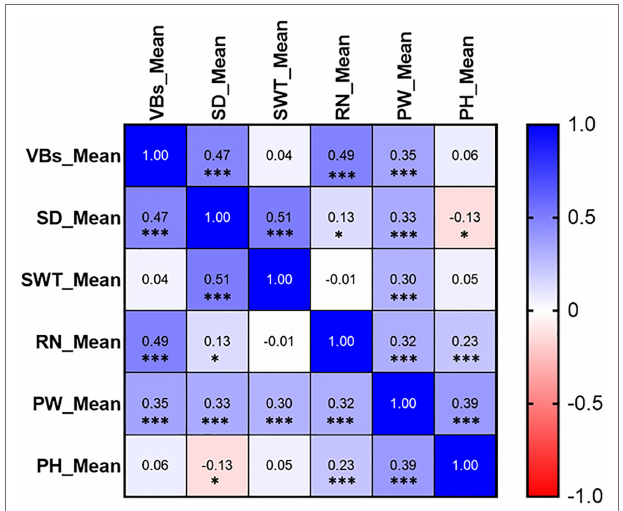
FIGURE 4 | Correlations between stem- and yield-related traits. The number in the middle of the cell is the correlation coefficient; “ * ” and “ *** ” refer to significant correlations ( p < 0.05 and p < 0.001). VB: number of big vascular bundle; SD: stem diameter; SWT: stem wall thickness; RN: the number of the spikelet; PW: panicle weight; PH: plant height.